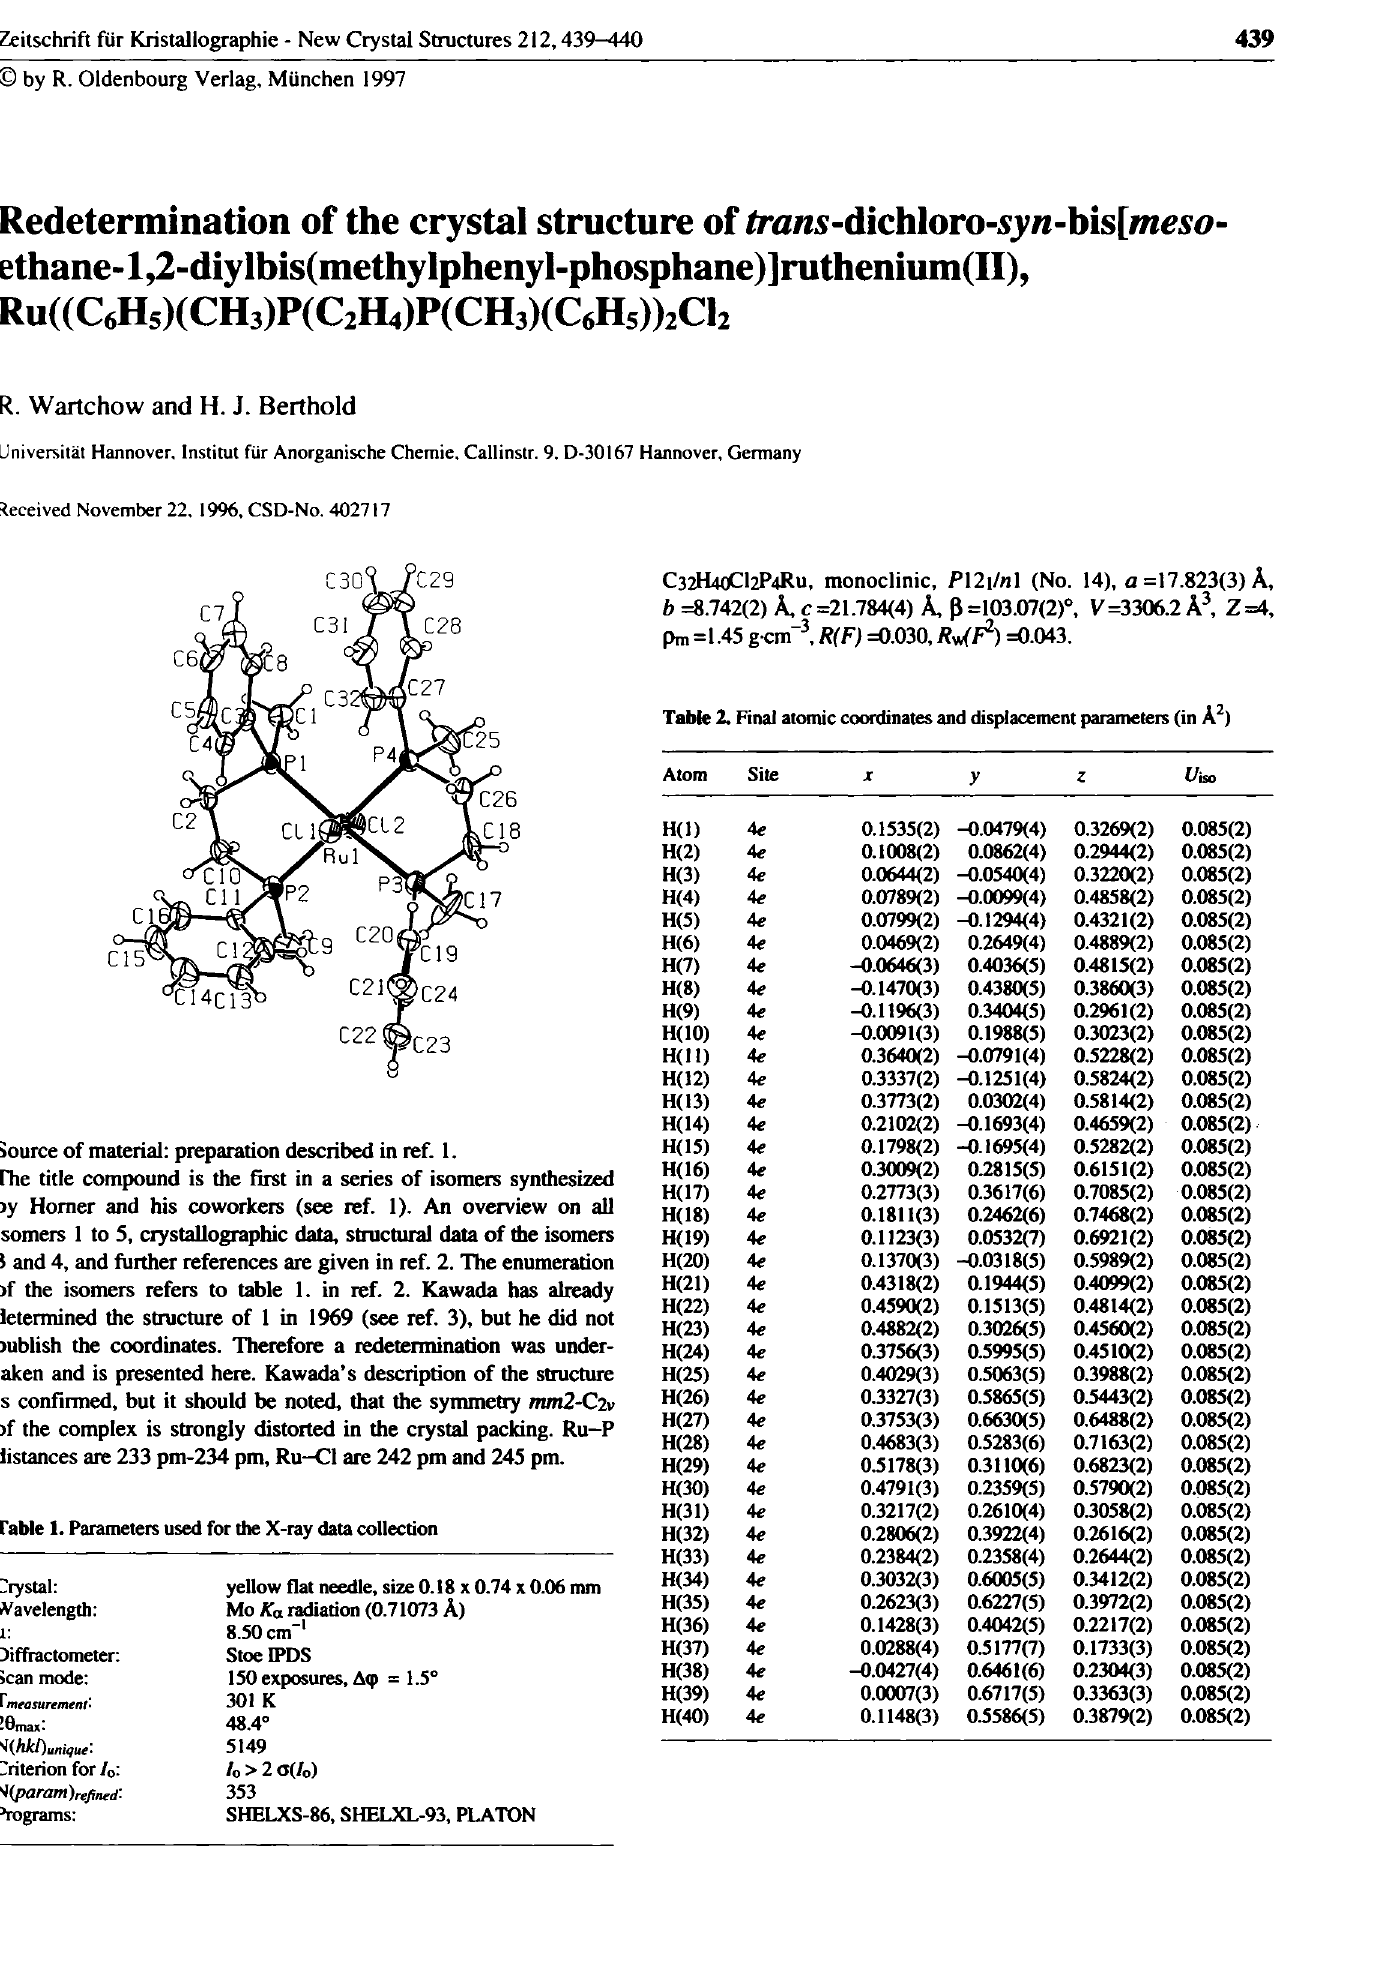
Table 1. Parameters used for the X-ray data collection Crystal :